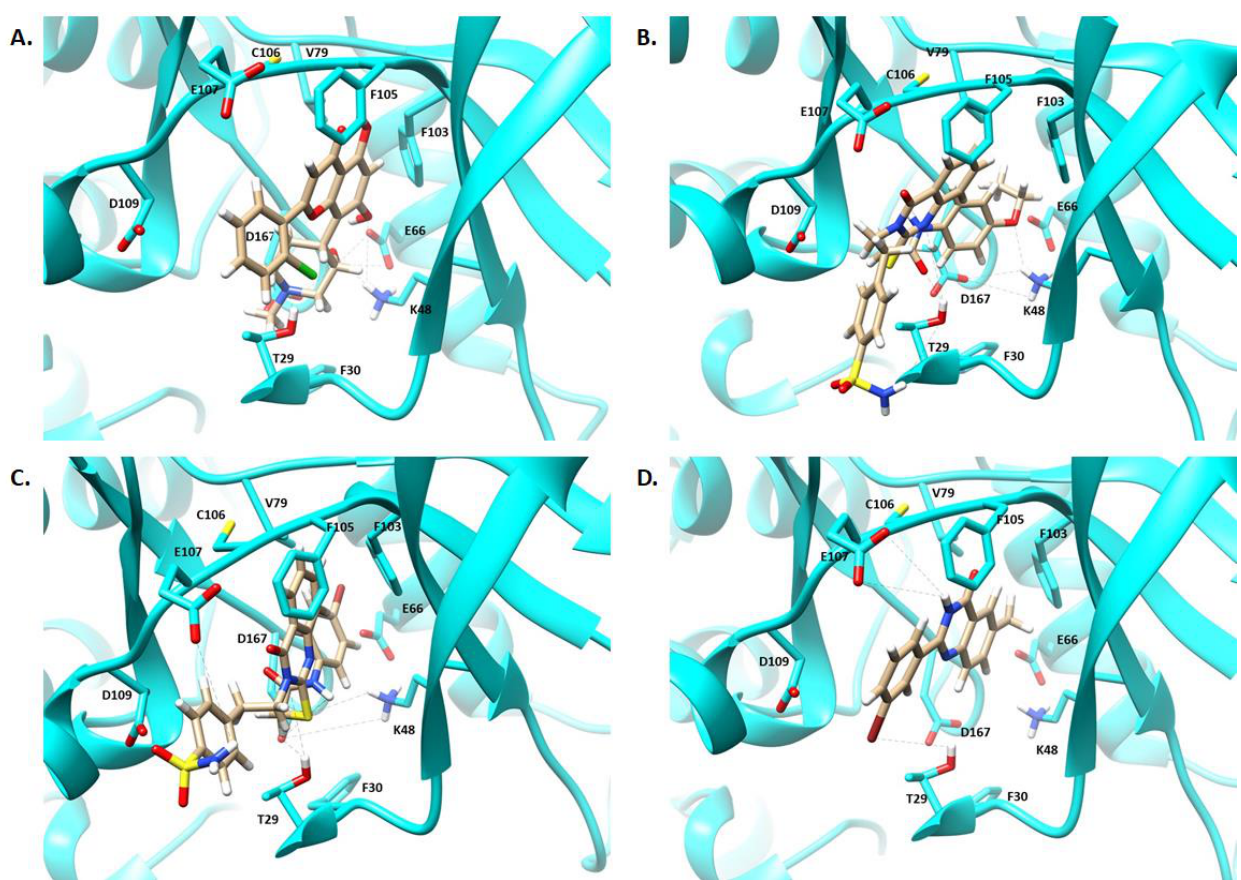
Figure 4 . Binding modes of ( A ) flavopiridol, ( B ) compound 7 , ( C ) compound 9 , and ( D ) compound 25 with CDK9.